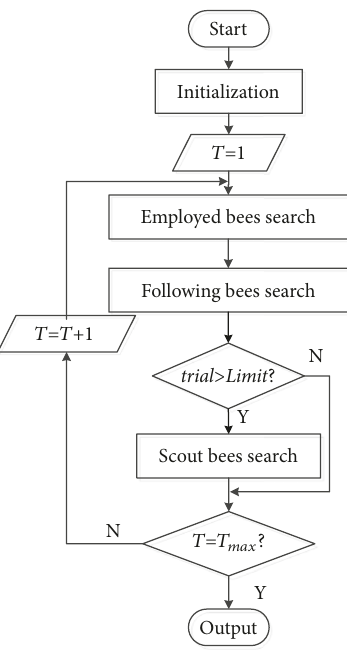
Figure 5: The flow chart of ABC algorithm.